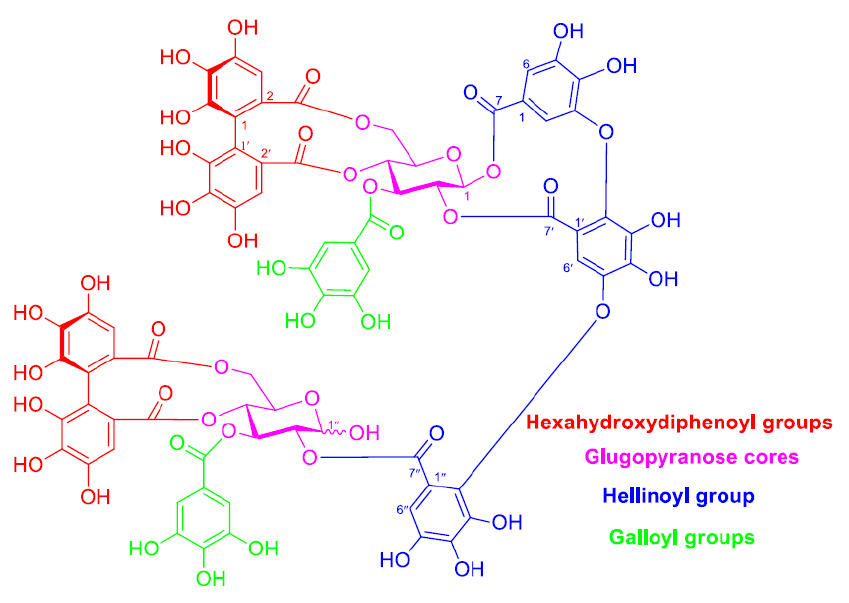
Figure 1. Molecular structure of tamarixinin A.